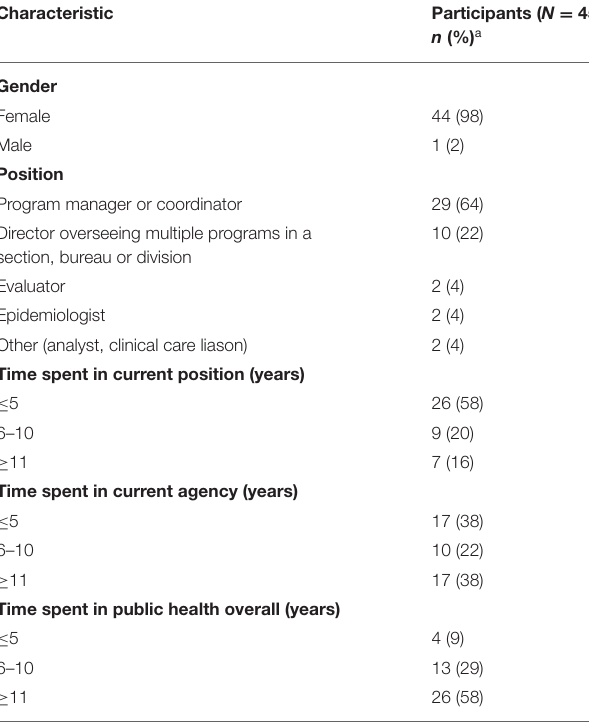
TABLE 1 | Demographic characteristics of state health department practitioners who participated in interviews on advice for ending ineffective programs, United States, 2019.